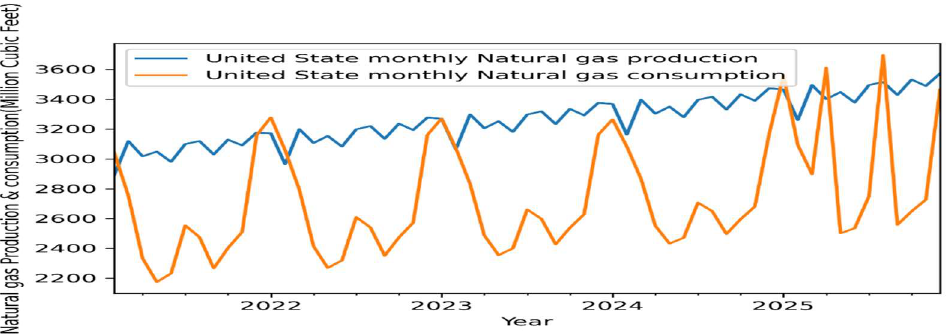
Figure 8. Graph of the United States monthly natural gas production and consumption until